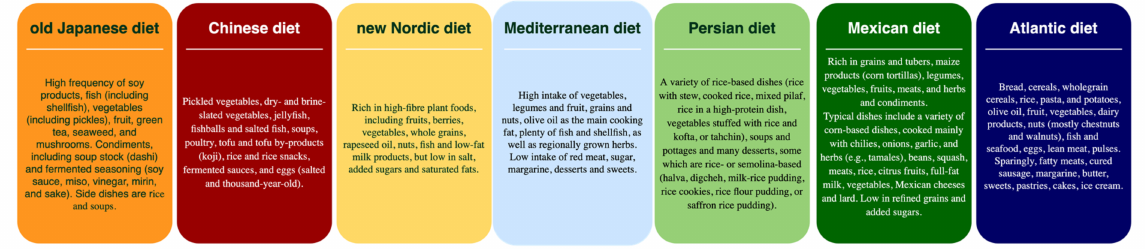
Figure 3. Characteristics of the regional diets included in the systematic